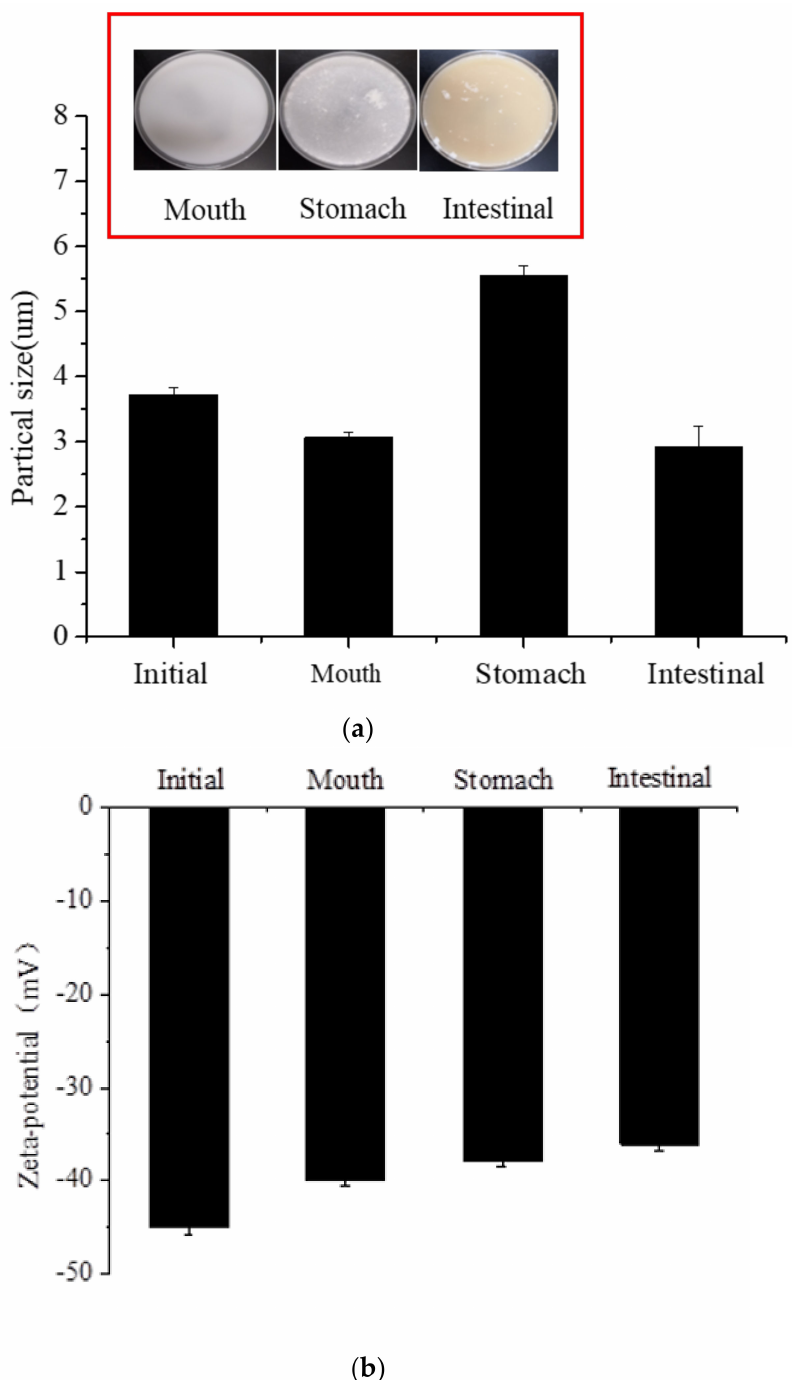
Figure 7. The particle size ( a ) and Zeta − potential ( b ) of the CaCO 3 S/O/W emulsions at different stages of